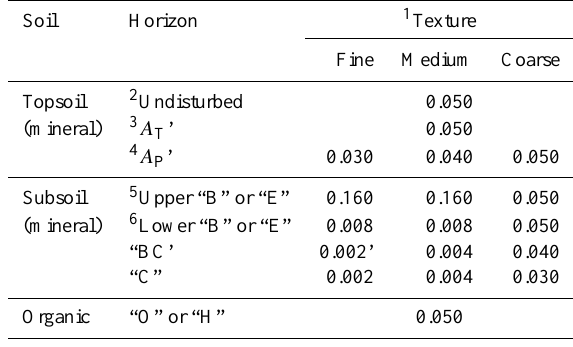
Table 4. Class pedotransfer functions for soil structure-related pa- rameters. The preferential flow class is determined using the deci- sion tree presented in Jarvis et al.